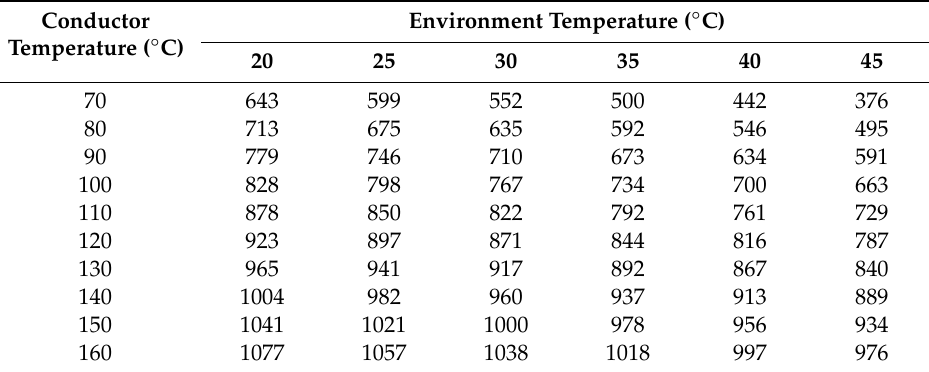
Table 5. Carrying capacity results calculated according to the parameters that are recommended by China’s electric power